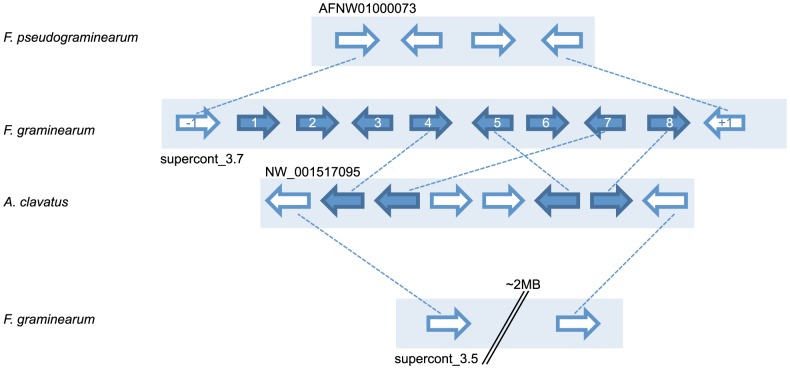
Orthologous genes of predicted C61 cluster.Predicted gene cluster in Fusarium graminearum and orthologous genes in F. pseudograminearum and Aspergillus clavatus are depicted in solid dark blue colors, adjacent genes are shown in white. Dashed lines illustrate orthologous groups. Enumeration in F. graminearum is according to Table 5.